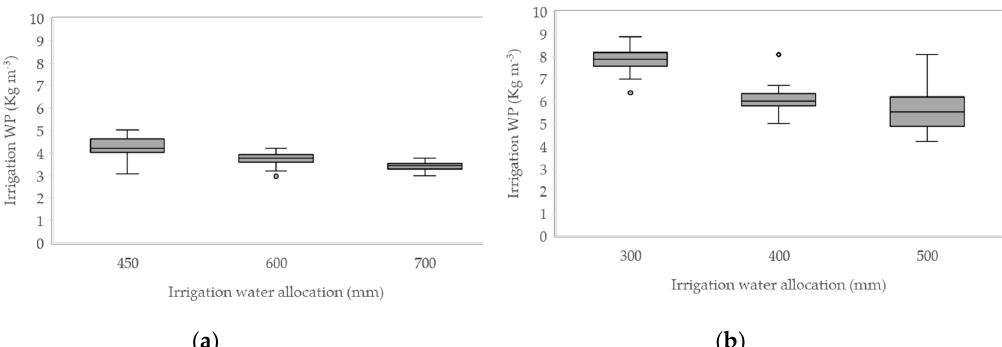
Figure 7. Simulated irrigation water productivity (WP) under three different irrigation water allocation scenarios for the 30 simulated seasons in the two main productive areas: ( a ) North (Valladolid), and ( b ) South (Sevilla). The box represents 50% of the data, where the box’s upper boundary represents the upper quartile (Q3) of the data, the lower boundary represents the lower quartile (Q1), and the line inside the box represents the median (Q2). The whiskers show the largest and smallest values. The circles denote outlier values.